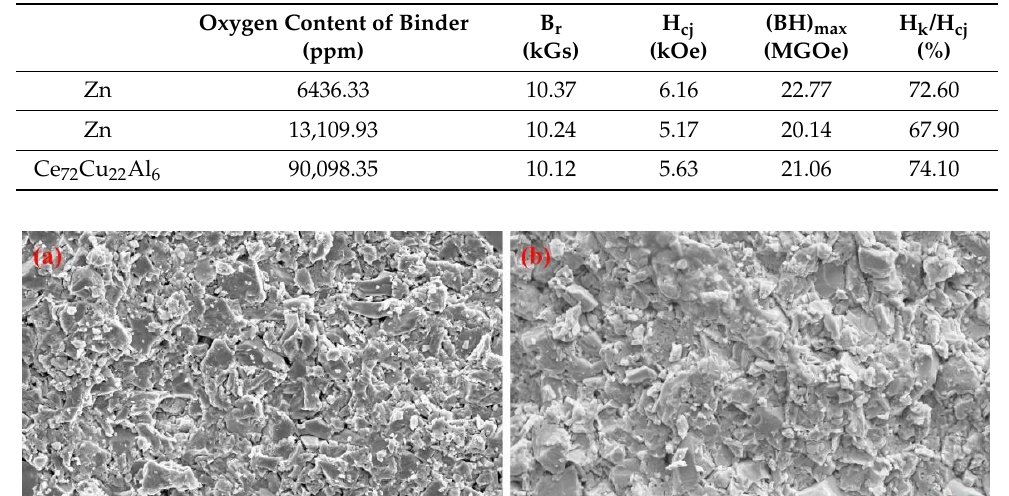
Table 2. Performance comparison of 5 wt.% Ce 72 Cu 22 Al 6 alloy and Zn with different oxygen content bonded magnets.